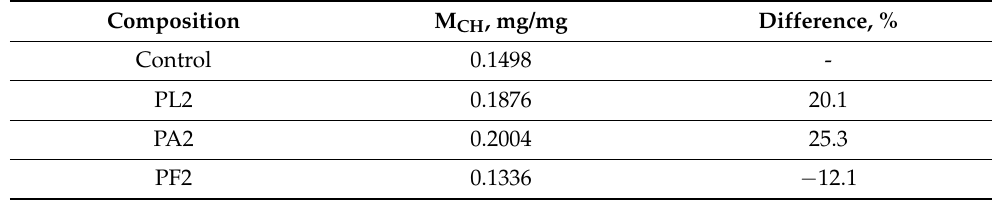
Table 8. Results of the calculation of calcium hydroxide content per unit of mass of cement.